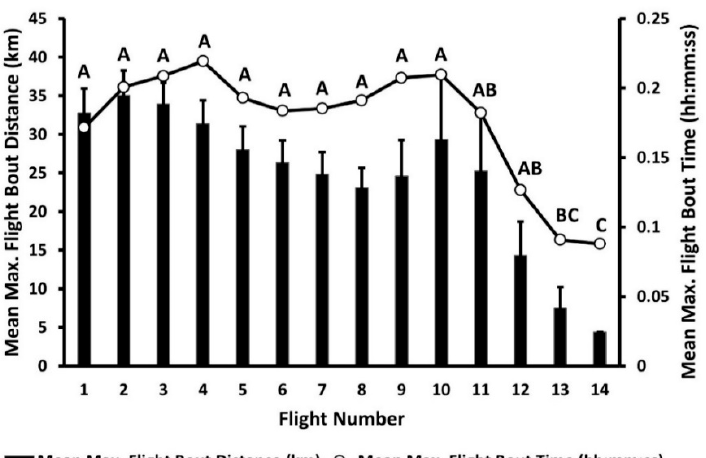
Figure 2. Mean (+SE) maximum flight bout distance (km) and mean maximum flight bout time (hh:mm:ss) exhibited by adult Rhynchophorus palmarum across 14 consecutive flight trials. Data points with different letters indicate significant differences at the 0.05 level for both data sets.